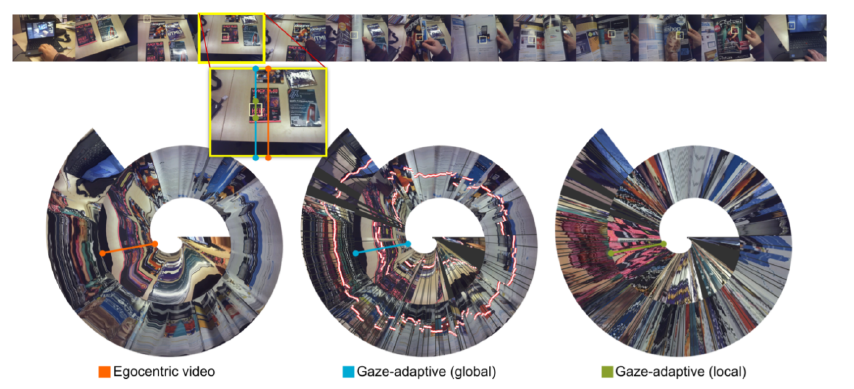
Figure 4. Gaze spiral diagram [26]. The lower part of the picture is the storage and presentation form of the gaze spiral, and the upper part of the picture is the unfolding picture of selecting a certain part from the gaze